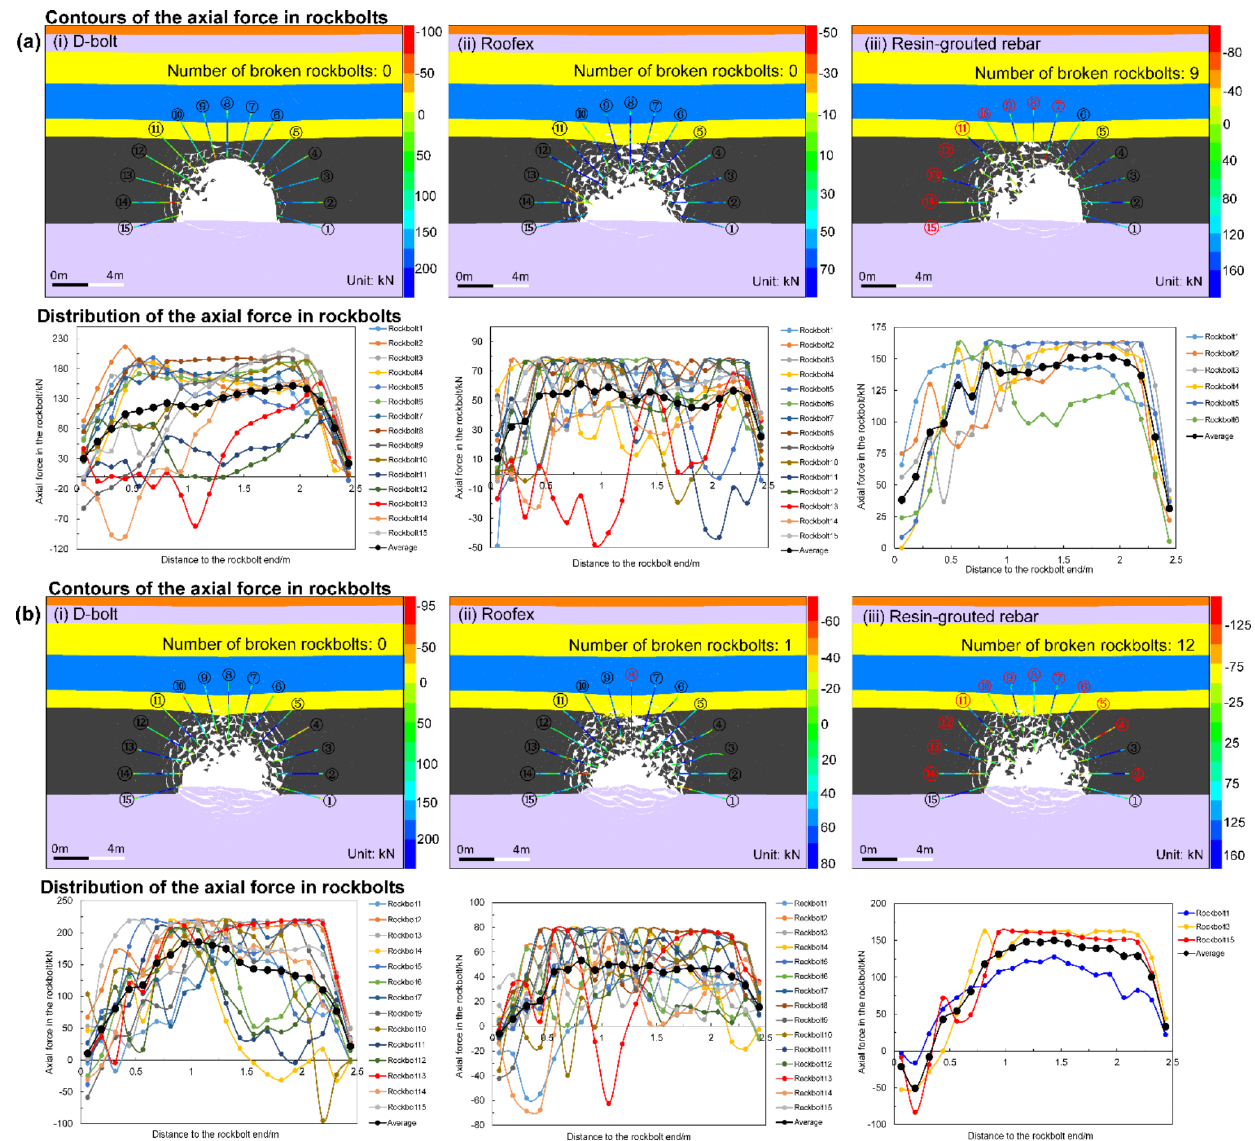
Fig. 21 Simulated contours and distribution of the axial force in rock- bolts for the tunnel supported by different rockbolts. a PPV = 0.2 m/s; b PPV = 0.8 m/s. The black and red numbers indicate intact and broken